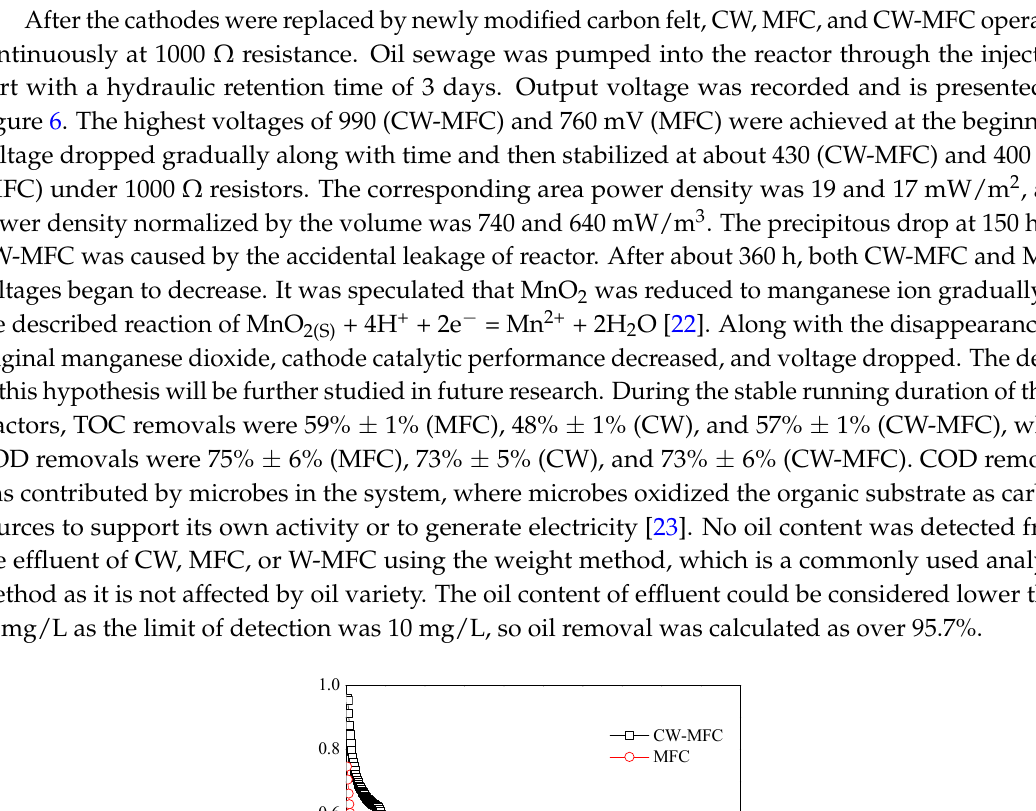
Figure 5. Anode and cathode potential curves.